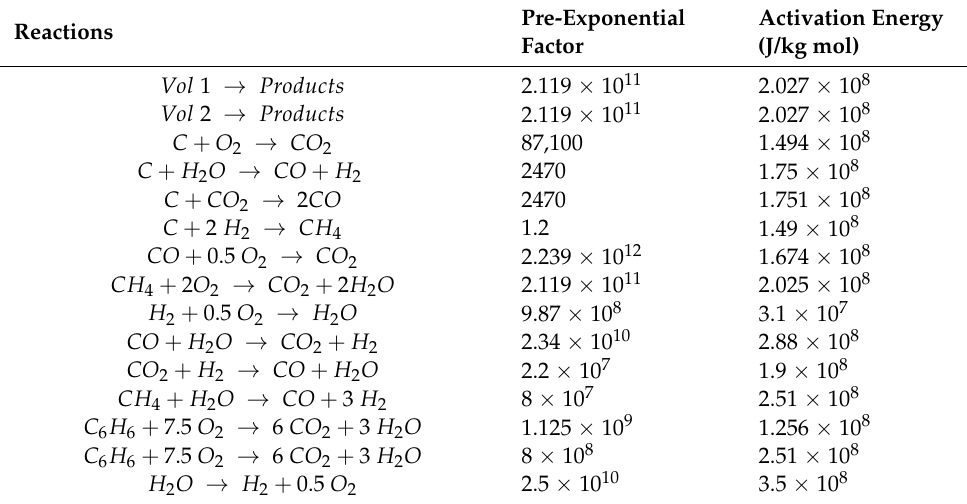
Table 1. Important reactions involved in the study